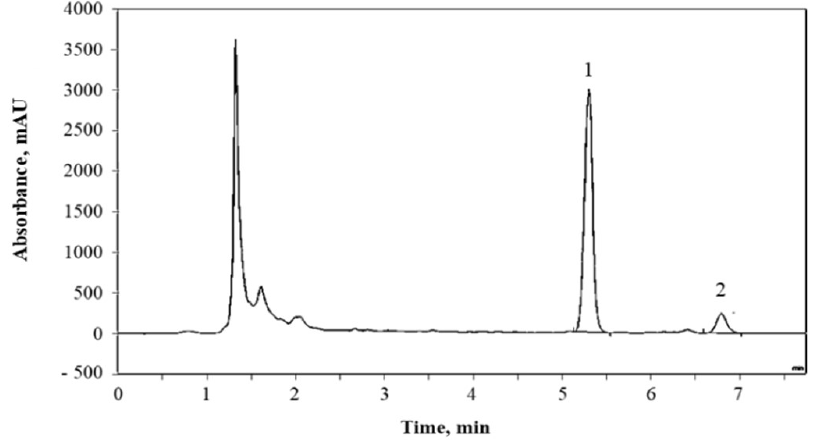
Figure 2. HPLC chromatogram (229 nm) of raw juice. The retention times of sinigrin (1) and gluconapin (2) are 5.3 and 6.9 min respectively.